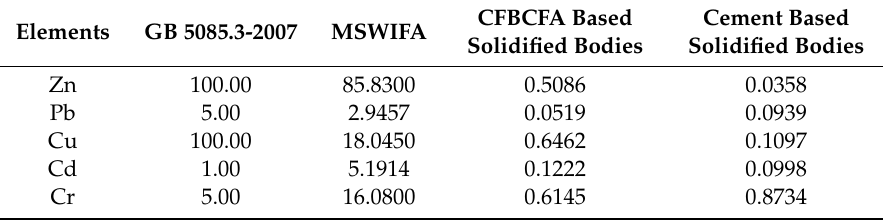
Table 4. Leaching results for MSWIFA and solidified bodies (mg /